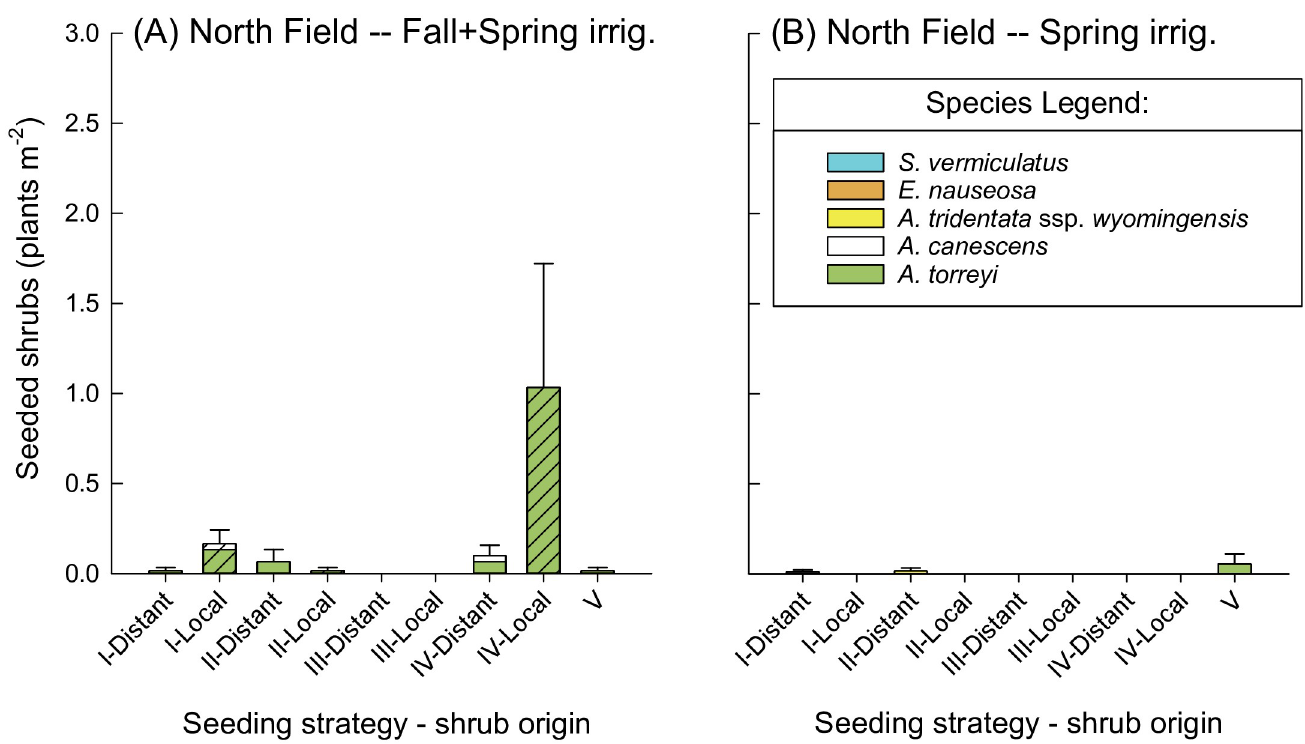
Fig 4. Seeded shrub density in the North Field in May 2016, by irrigation treatment, seeding strategy, and shrub origin. Seeded shrub density (plants m -2 ) in the North Field in May 2016, shown by seeding strategy (I-IV; see Table 1) and shrub origin for the (A) North Field, Fall+Spring irrigation, and (B) North Field, Spring irrigation. “Distant” and “Local” on the X-axis refer to shrub seed origin, which is also indicated by hash marks for local origin, or no pattern for distant origin. Strategy V (unseeded control) is shown in both panels for visual comparison of shrub recruitment in areas that did not receive seed addition.